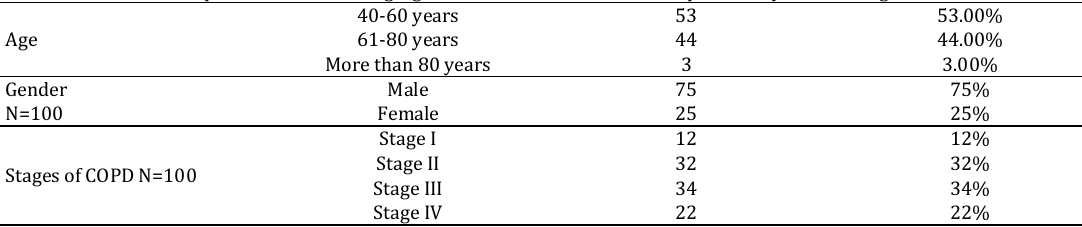
Table 1. Distribution of patients in terms of age, gender, and chronic obstructive pulmonary disease stages